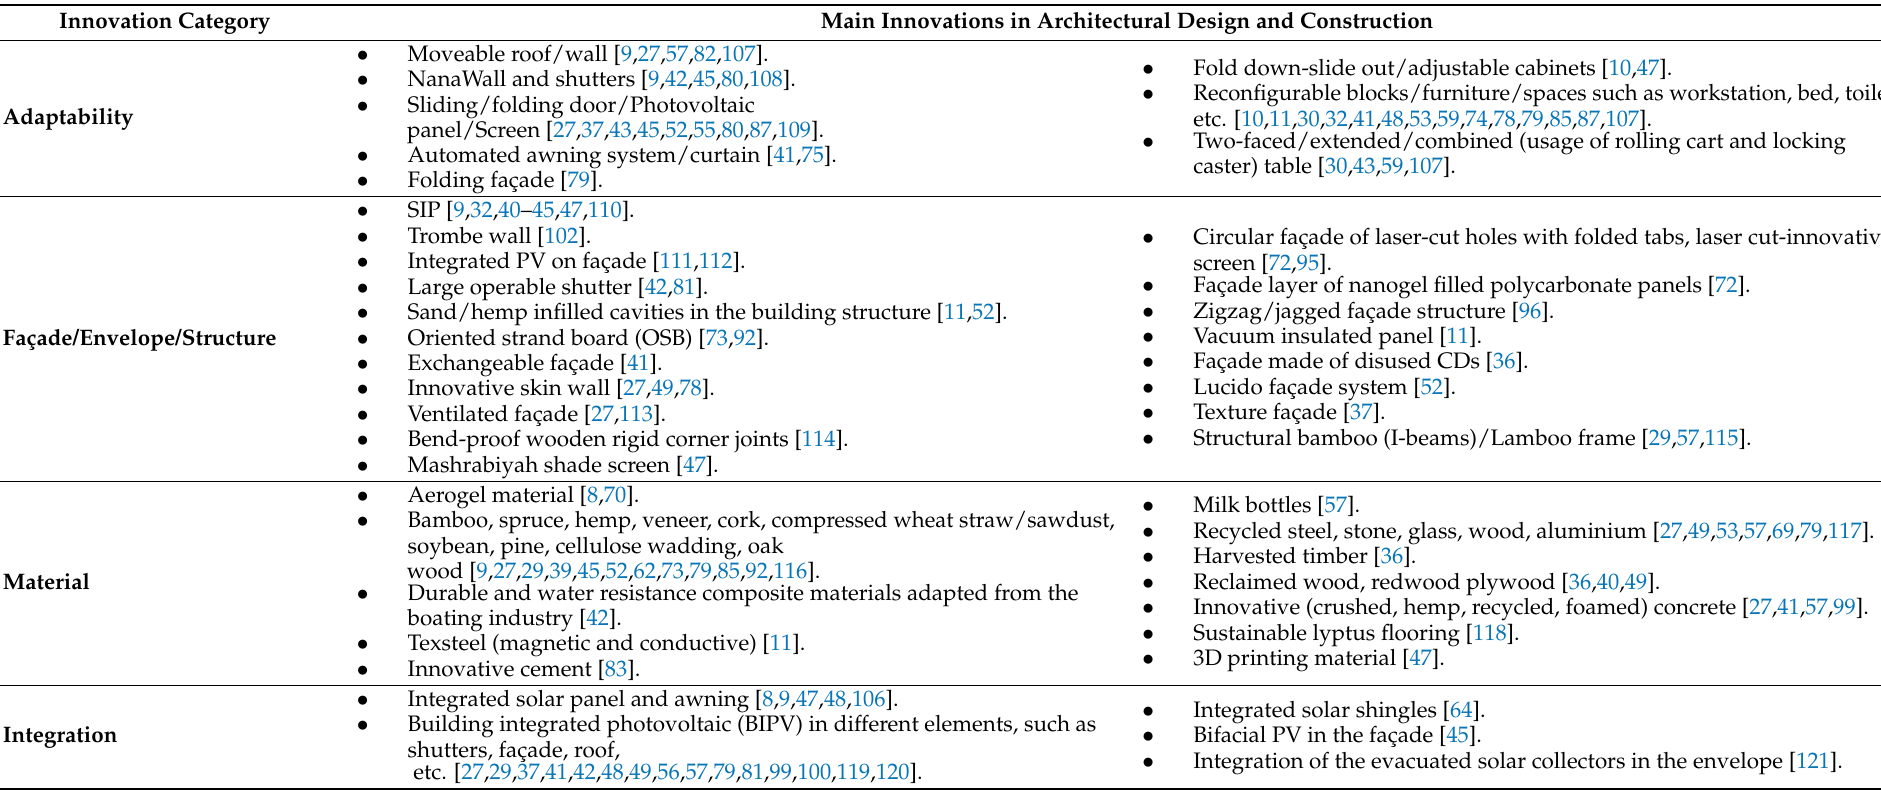
Table 3. Main innovations in architectural design and